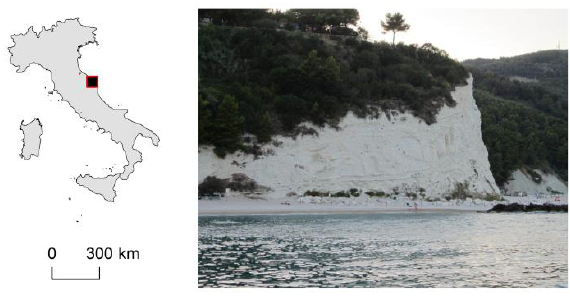
Figure 1. Location map of the study area, with the analyzed section of the coast